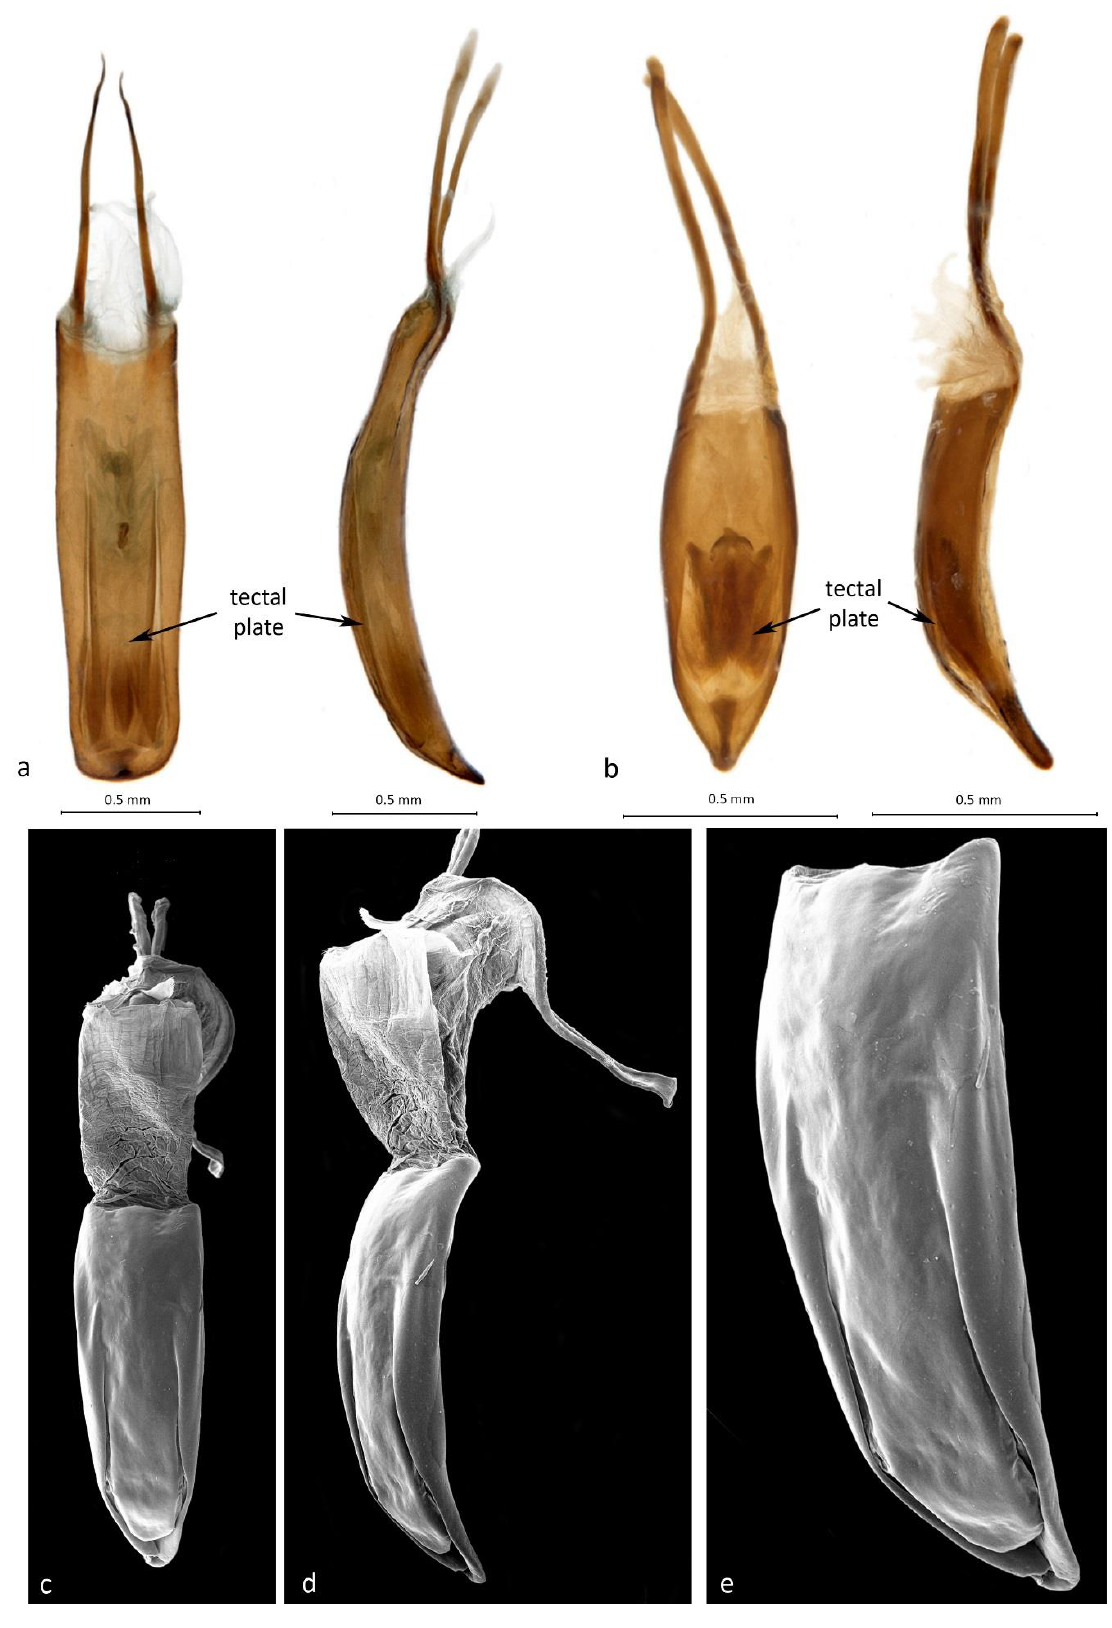
Figure 14. Tectal plates of Cryptoplini: ( a ) penis of Sigastus fascicularis Pascoe, dorsal and lateral view; ( b ) penis of Haplonyx casuarinae (Lea), dorsal and lateral view; ( c ) aedagus of Haplonyx maximus Lea, dorsal view (tegmen pulled forward over temones); ( d ) aedagus of Haplonyx maximus Lea, dorsolateral view (tegmen pulled forward over temones); ( e ) apical part of penis of Haplonyx maximus Lea, dorsolateral view.